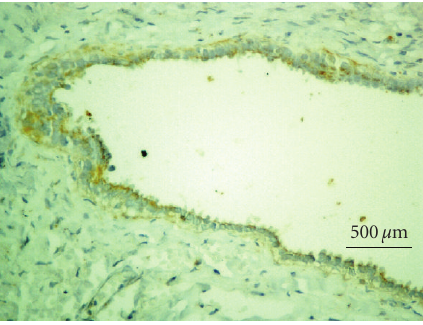
Figure 1: Immunohistochemistry negative staining of anti-iNOS polyclonal antibody (serous ovarian cyst, 400x, diaminobenzidine).